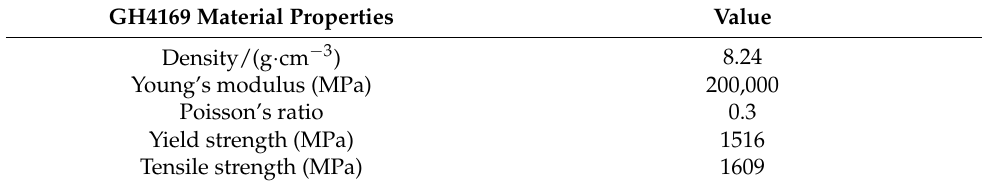
Table 1. Main material properties of